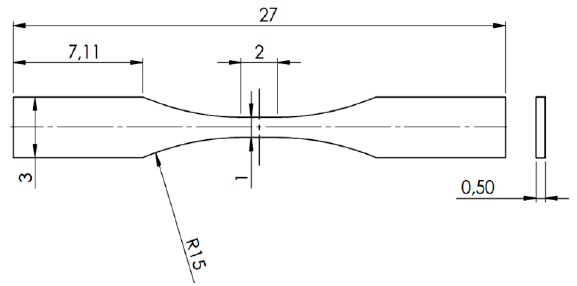
Figure 13. Geometry of an M-TT test specimen for testing brittle materials.